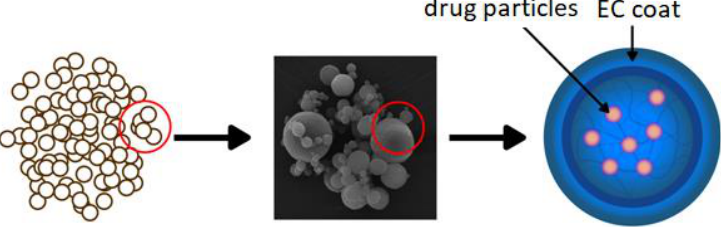
Figure 9. Schematic illustration of microparticles as a drug delivery system. Reprinted with permission from Reference [16]. Copyright 2019 MDPI.